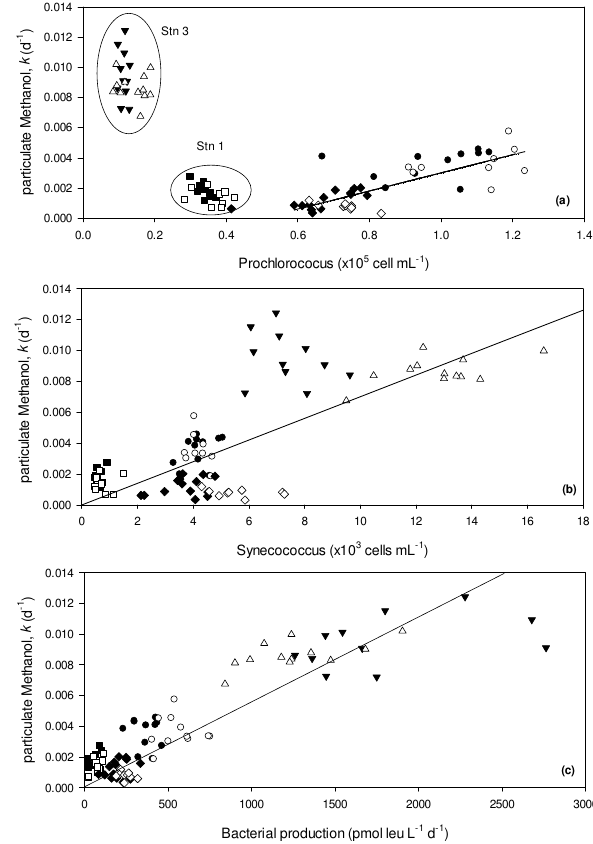
Figure 6 (cid:1)(cid:10)(cid:2)